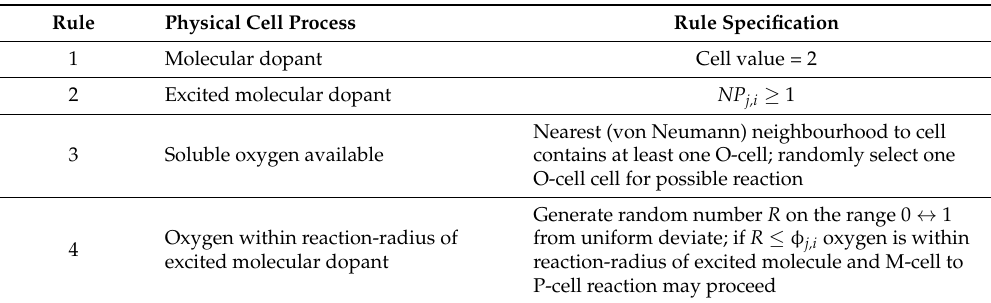
Table 1. CA rule ‐ set listing the various specifications that must be met in order for the associated physical process to apply to a cell under consideration.